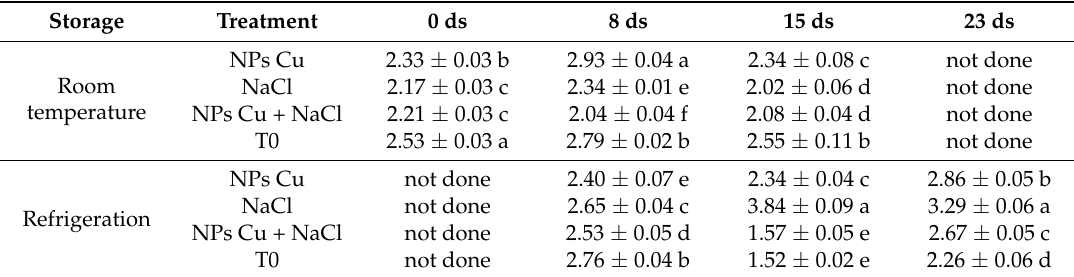
ds: days of storage. NPs Cu: plants without stress and with application Cu nanoparticles to 250 mg L − 1 . NaCl: plants with stress by NaCl. NPs Cu + NaCl: plants with stress by NaCl and with application Cu nanoparticles at treatments according to Fisher’s least significant difference test ( p ≤